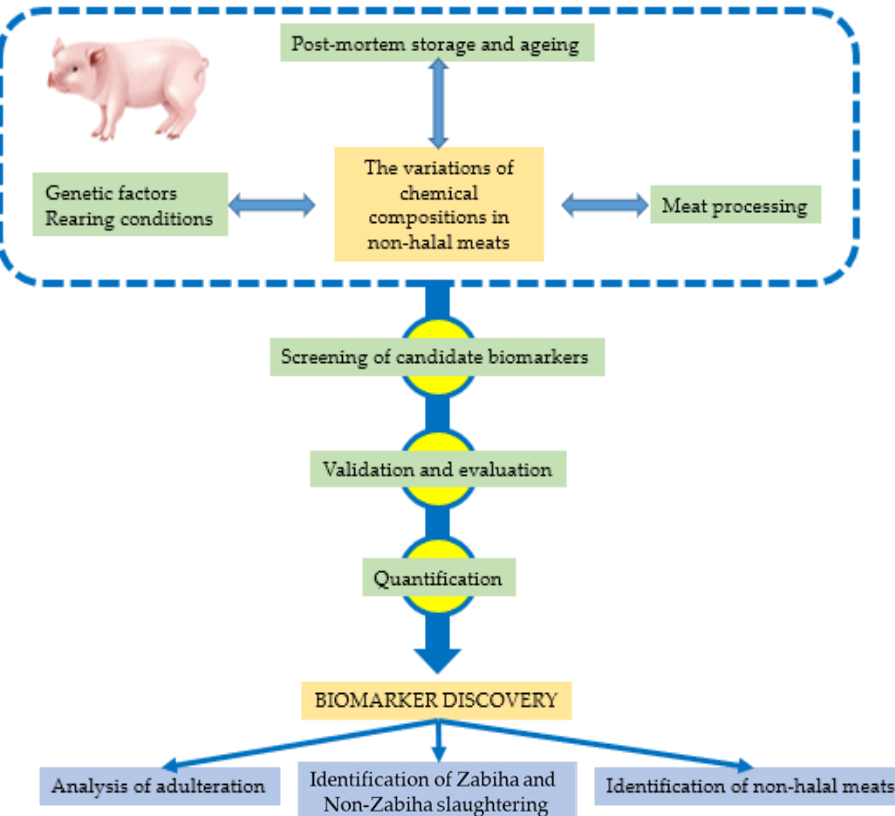
Figure 1. The workflow used to search metabolites used as biomarkers, intended for the identification of halal meats. Adapted from Ref. [36].